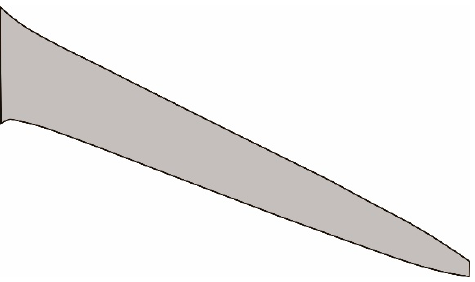
Figure 13. Planform of swept wing configuration used for Figure 12 (from [23]).